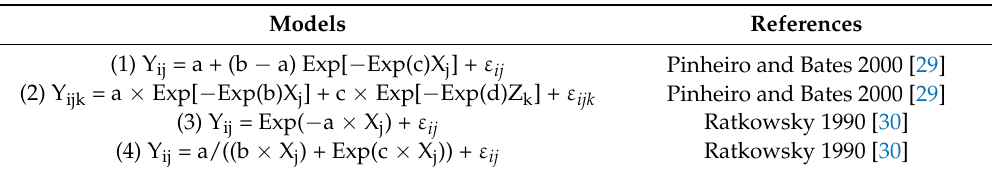
Table 3. Equations used for stand yield loss modeling to different treatments of intensity of competing vegetation control of planted E. globulus